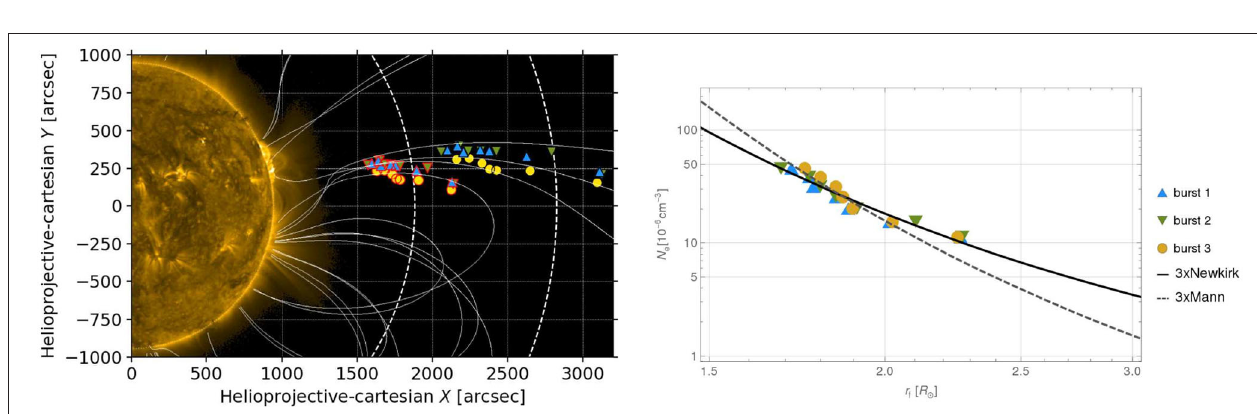
higher than the standard 0.1-0.3c velocities typically